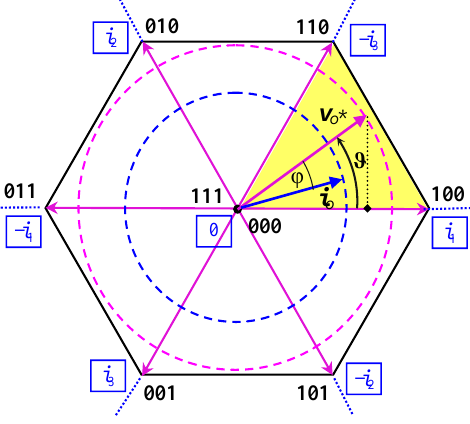
Figure 2. Space vector diagram of inverter output voltage emphasizing the input dc current (framed) for each inverter state (S 1 S 2 S 3 ).